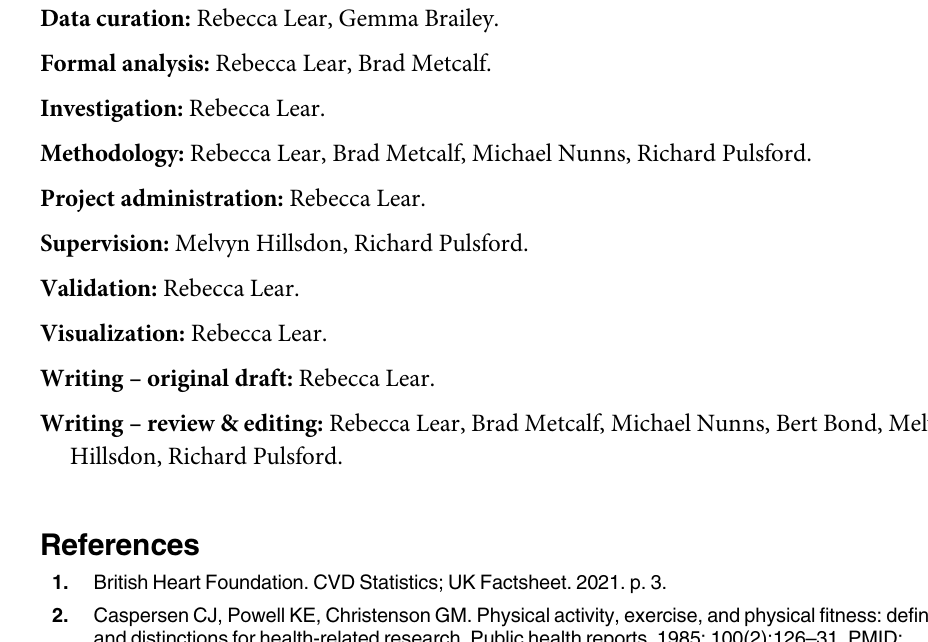
S5 Fig. Forest plot of pooled analysis without Authors’ manual conversion of univariate r values to partial r, indicating the association between habitual moderate-vigorous or total physical activity and carotid-femoral pulse wave velocity, grouped by those reporting uni- variate r and partial r. Top indicates univariate r as reported in publication and bottom indi- cates partial r adjusted for any number of covariates as reported in the publication. Random effects model. Grey squares indicate individual study association with 95% confidence inter- vals (CI). Solid vertical line represents line of no difference. Dashed vertical line and grey dia- mond represents the overall summary estimate of association. (TIF) S6 Fig. Forest plot of pooled analysis without Authors’ manual conversion of univariate r values to partial r, grouped by those utilising accelerometer and those utilising question- naire in the measurement of habitual physical activity. Random effects model. Grey squares indicate individual study association with 95% confidence intervals (CI). Solid vertical line represents line of no difference. Dashed vertical line and black diamond represents the overall summary estimate of association. (TIF) S1 Table. Full data extraction summary for all 29 included studies.